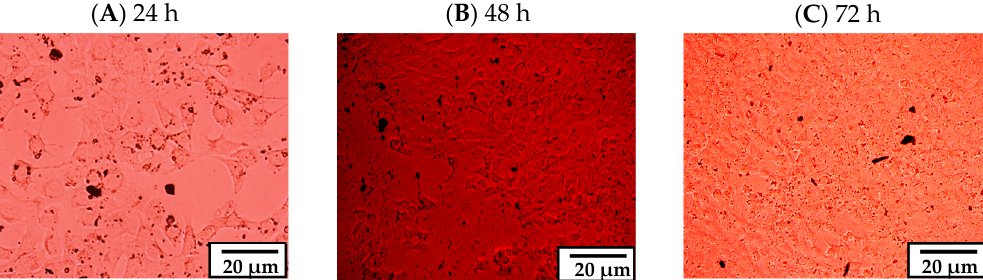
Figure 5. Representative images in higher resolution showing the effect of GBA (100 µg/mL) on MCF7 cells after ( A ) 24 h ( B ) 48 h, and ( C ) 72 h of treatment. Scale bar: 20 µm. The e ff ect of GBA (0.1 mg / mL) on MCF-7 cells after 24, 48, and 72 h of treatment is shown in higher resolution optical images as below.